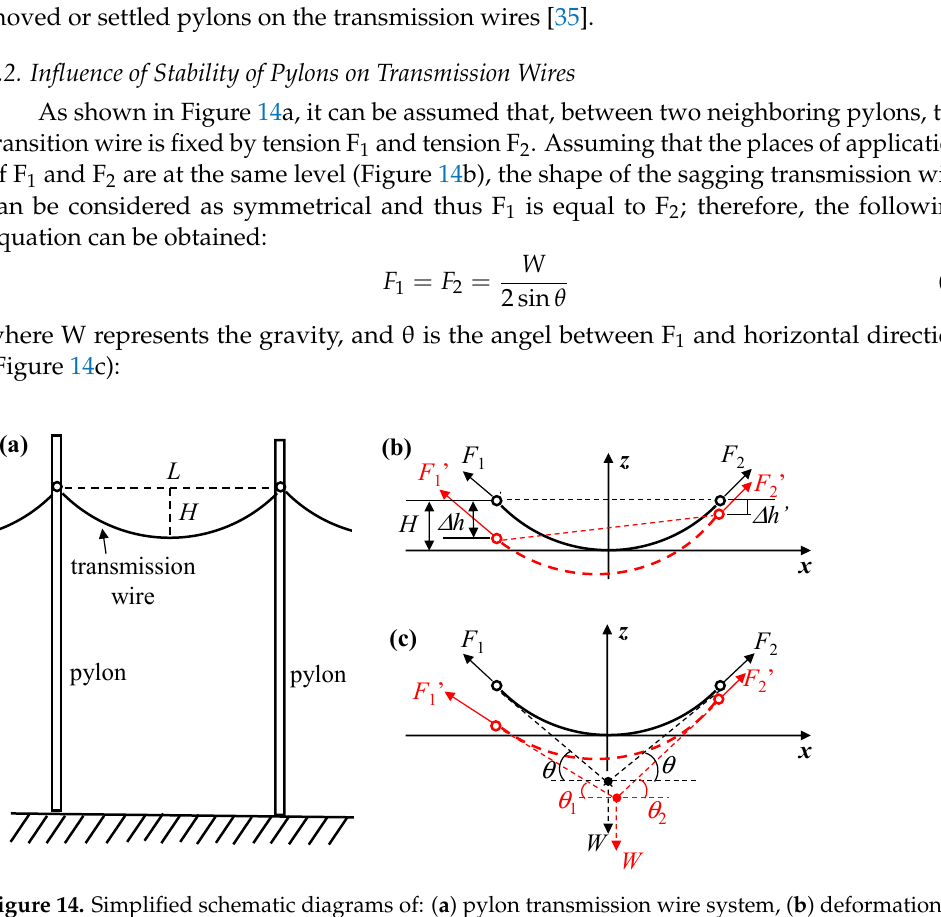
Figure 14. Simplified schematic diagrams of: ( a ) pylon transmission wire system, ( b ) deformation of transmission wire caused by the settling pylons, and ( c ) forces on the transmission wire.